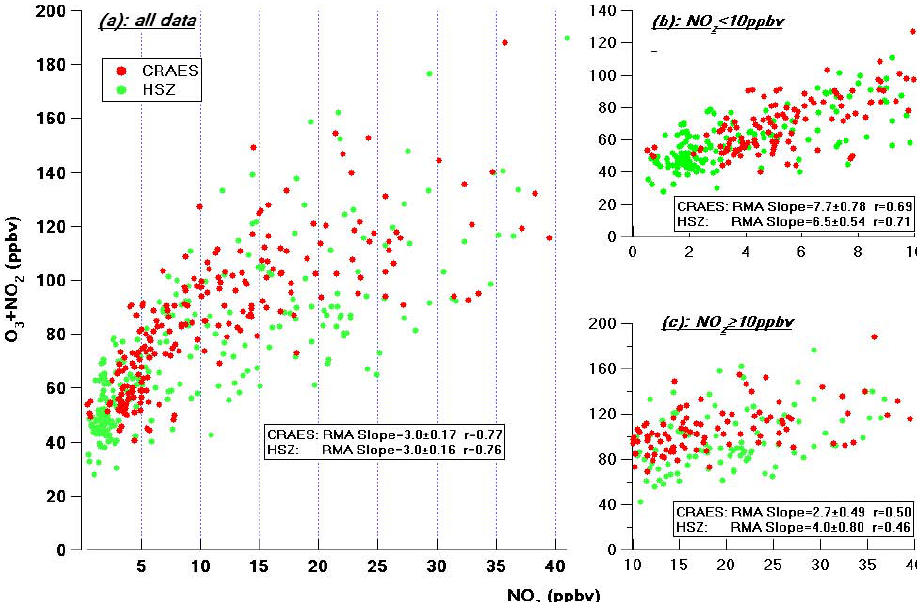
Fig. 8. Scatter plots of O 3 +NO 2 versus NO z in the afternoon (12:00–17:00) at CRAES (red) and HSZ (green): (a) all data, (b) NO z < 10ppbv, and (c) NO z ≥